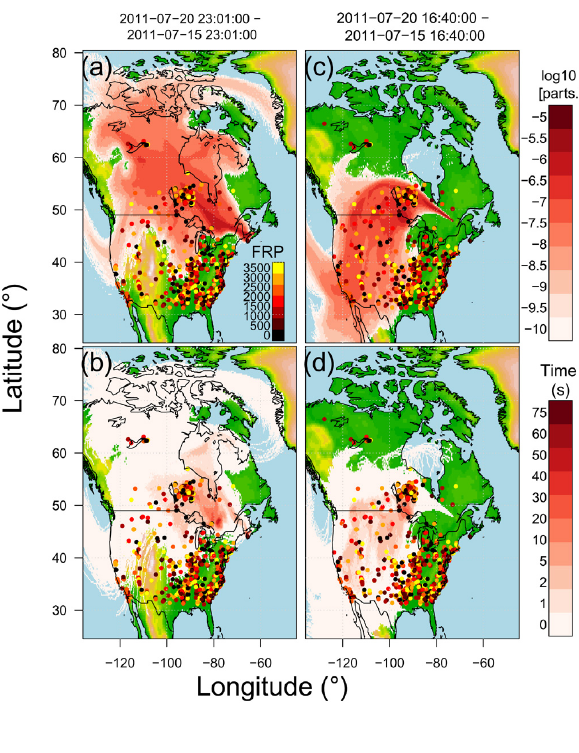
Fig. 8. NAME total column ( a and c ) and surface ( b and d ) sensi- tivity footprints for two BB plumes sampled during flight B623 ( a and b ) and B622 ( c and d ). Darker shading represents a greater sen- sitivity to that region. Markers are active fires detected by MODIS for the 5 days prior to the flight, and they are coloured by the fire radiative power